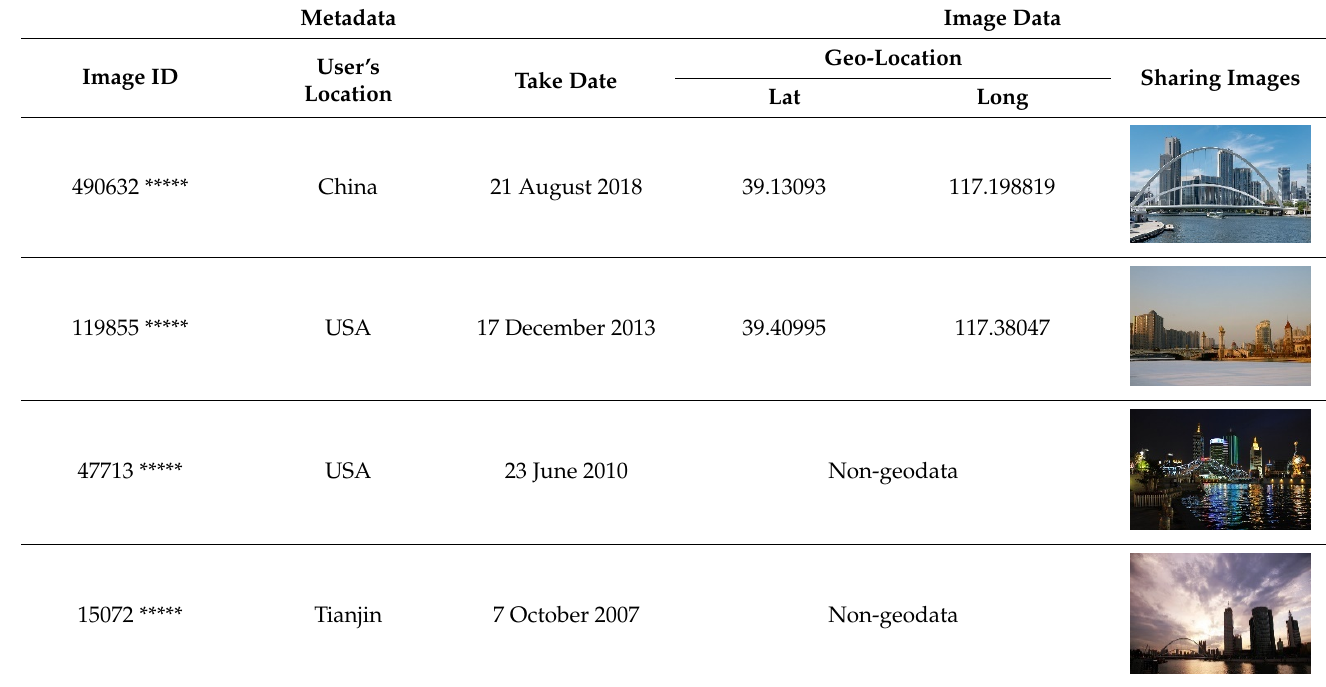
Table 1. Example of Haihe River Flickr image data obtained through the Flickr API.